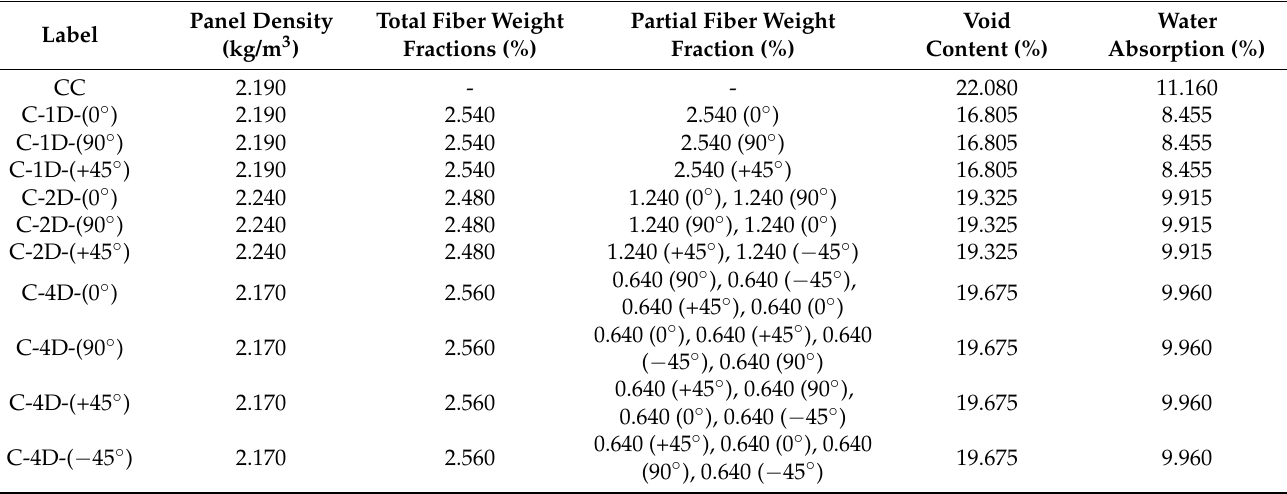
Table 3. Multiaxis 3D carbon concrete